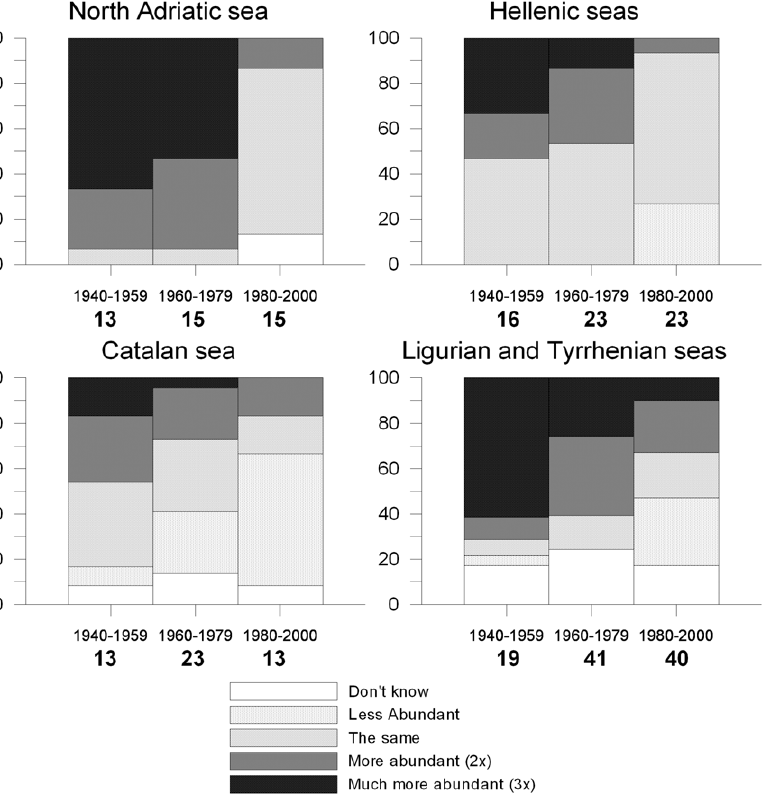
Figure 3. Trends in catches of cartilaginous fish. Frequencies in the responses to questions on catches of cartilaginous fish (sharks and rays) in each Mediterranean case study, by time period.